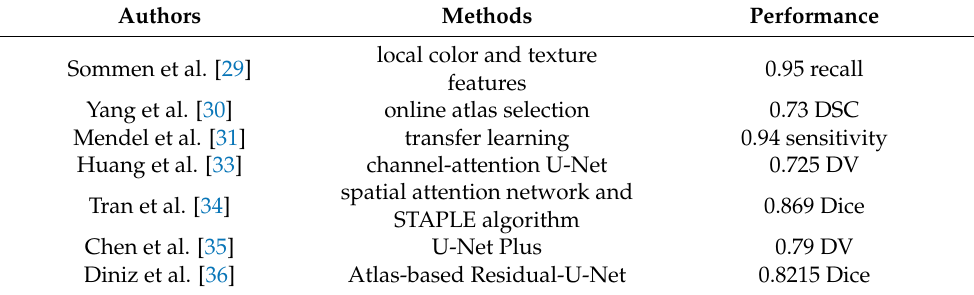
Table 2. Comparison of the methods for esophageal lesion segmentation.